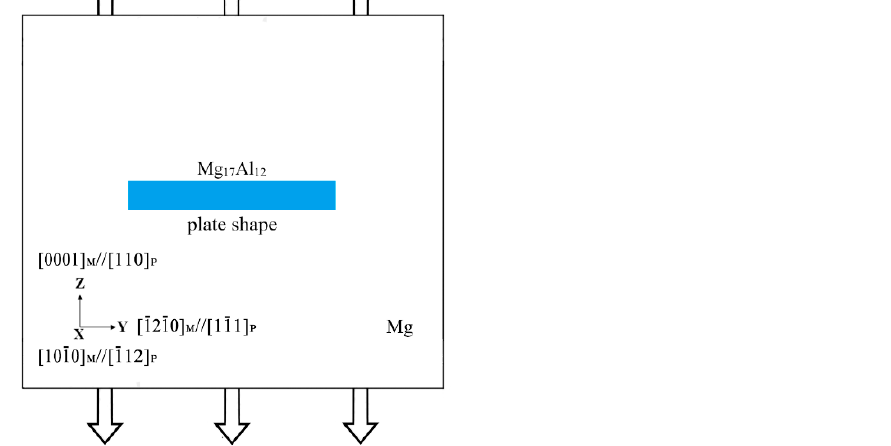
Figure 1. Initial schematic model of the single-crystal magnesium with a precipitate.